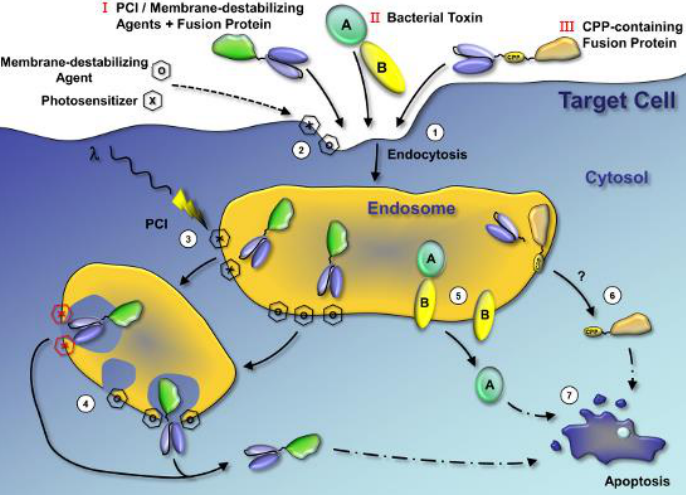
Figure 4. Mechanism of endosomal escape by drug candidates. Reproduced with permission from Fuchs et al. (2013), © MDPI, 2013 [160] .